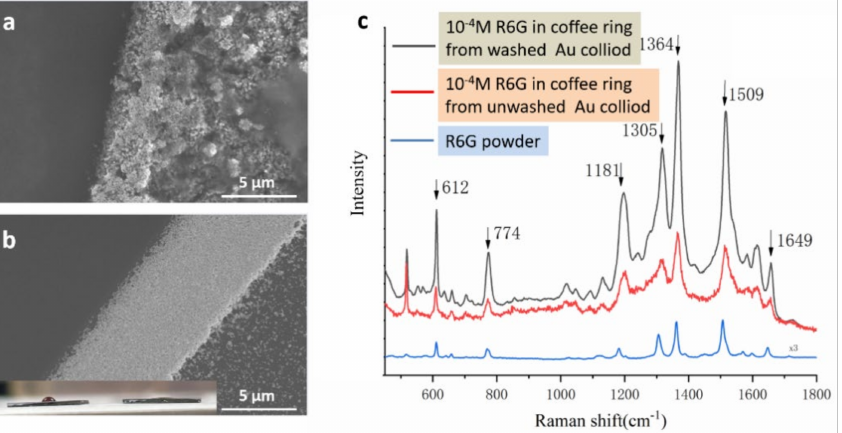
Figure 2. SEM images of the coffee ring edges ( a , b ) and the Raman spectra of 10-4M R6G with the coffee ring ( c ) formed from both unwashed and washed Au